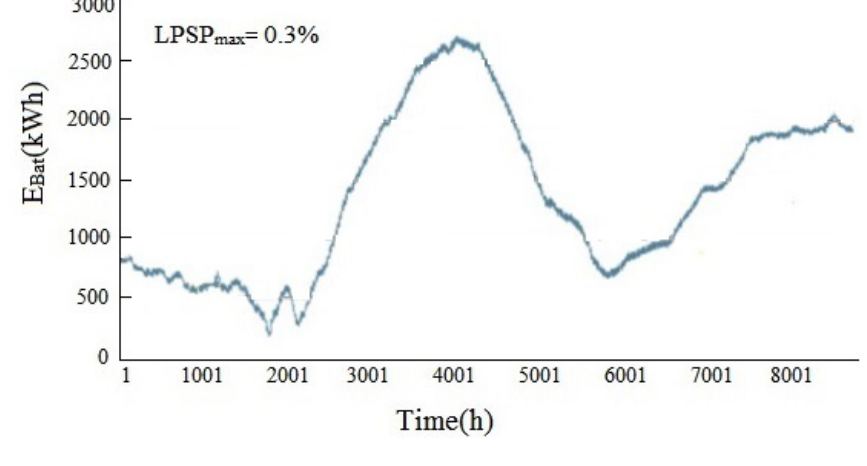
Figure 11. Energy in